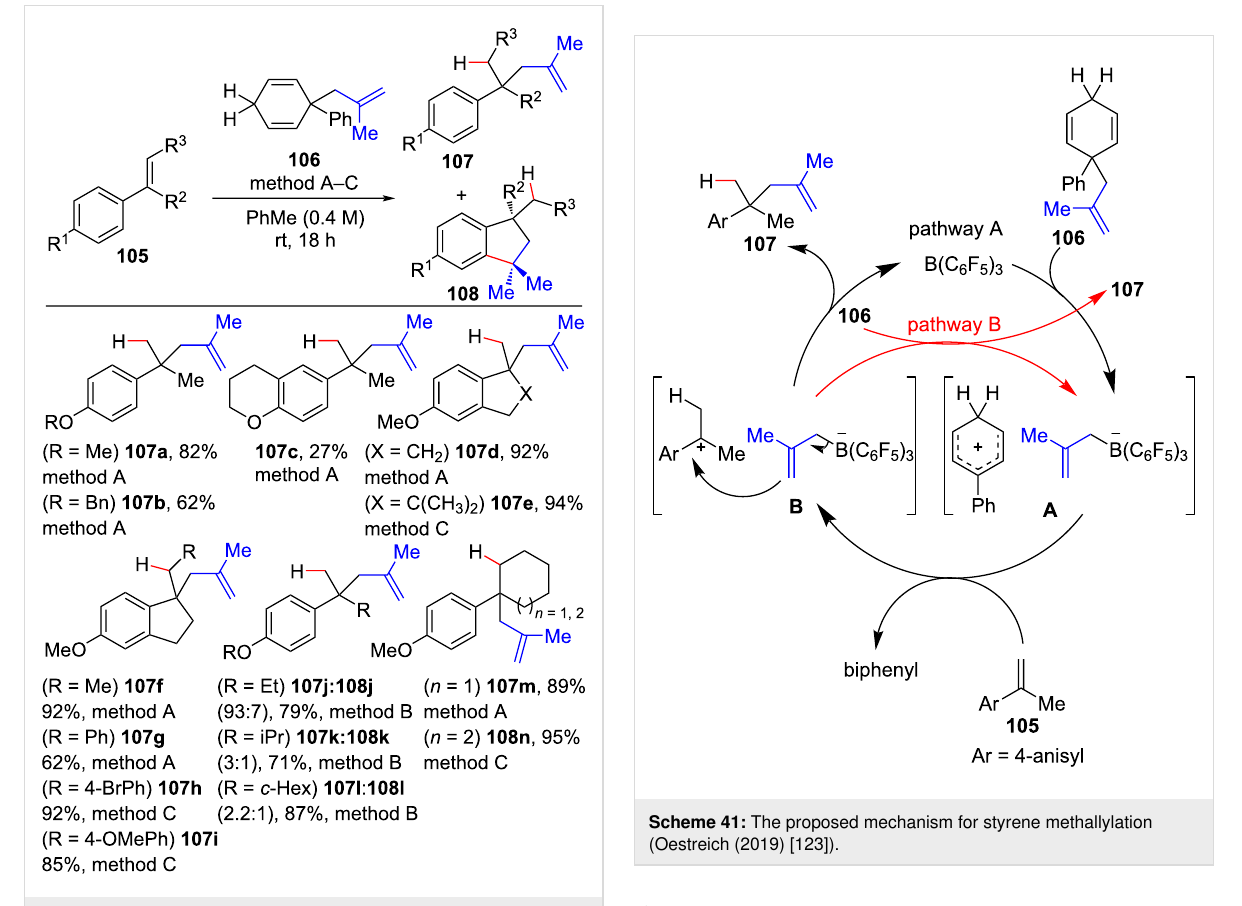
Scheme 40: Scope of the Lewis acid-catalyzed methallylation of elec- tron-rich styrenes. Method A: B(C 6 F 5 ) 3 (5.0 mol %), surrogate